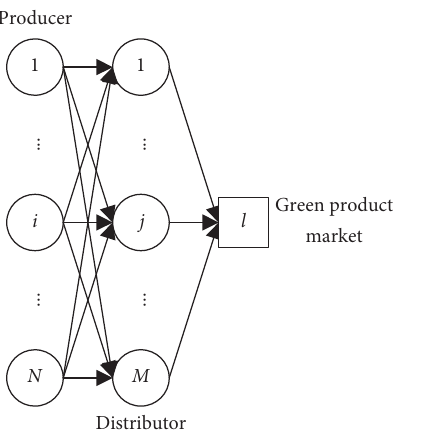
Figure 4: Structure of the coordinated optimization for the